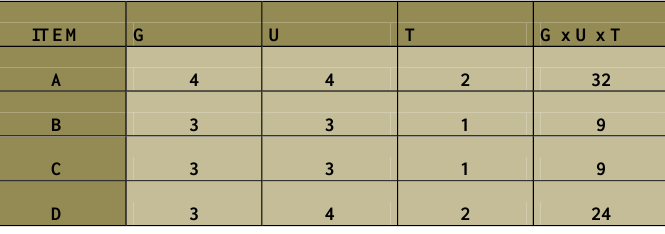
Fonte: Autores, (2017).